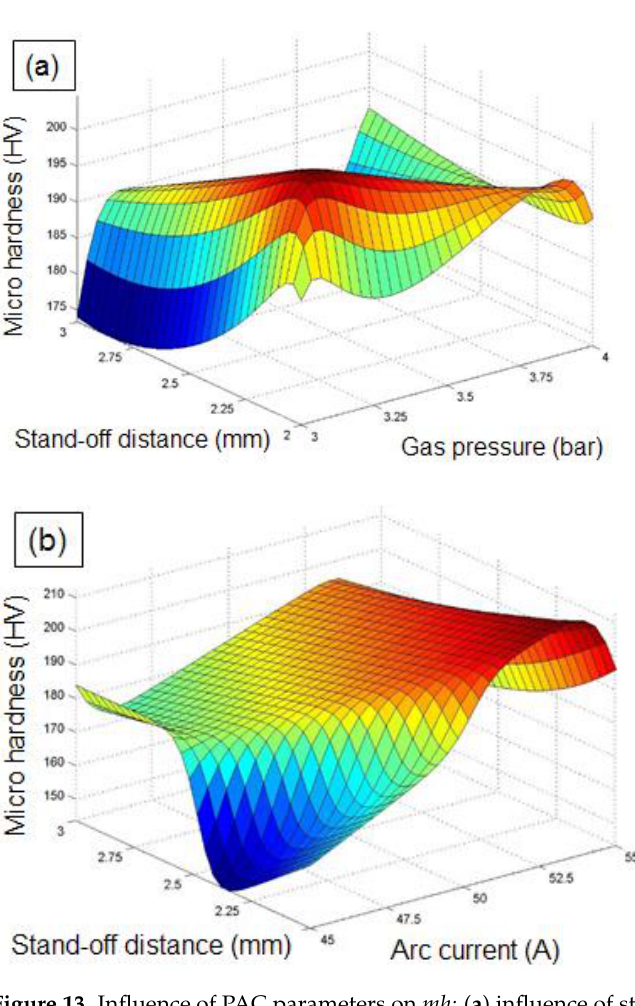
Figure 13. Influence of PAC parameters on mh: ( a ) influence of stand-off distance and gas pressure on mh , and ( b ) influence of arc current and stand-off distance on mh .